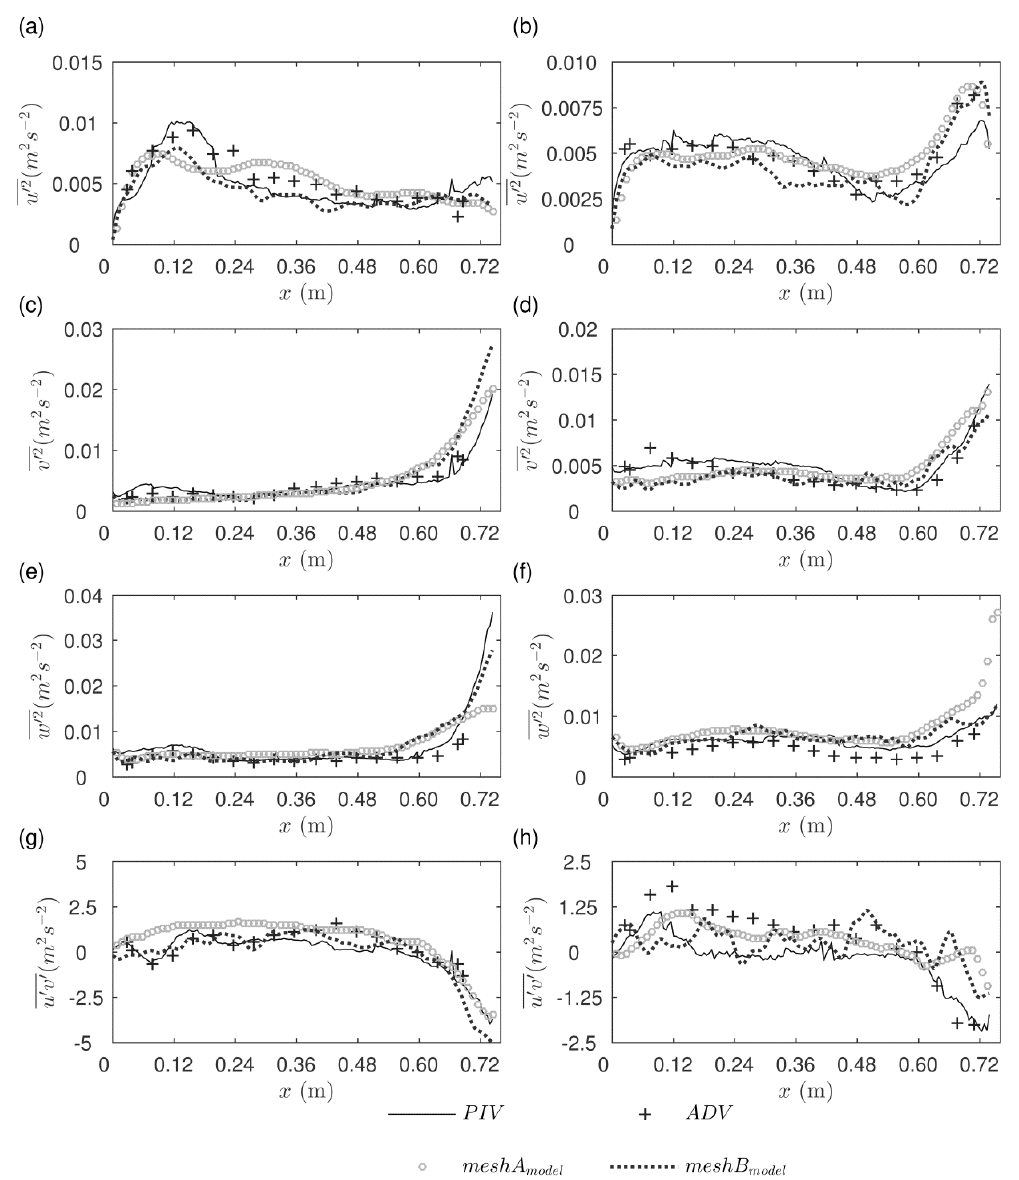
Figure 6. Longitudinal variation of Reynolds normal stress components and Reynolds shear stress parallel to the bottom component: ( a , c , e , g ) planes 1 and 6 intersection ( y = 0.36 m and z = 0.04m); ( b , d , f , h ) planes 2 and 5 intersection ( y = 0.20 m and z = 0.088 m).